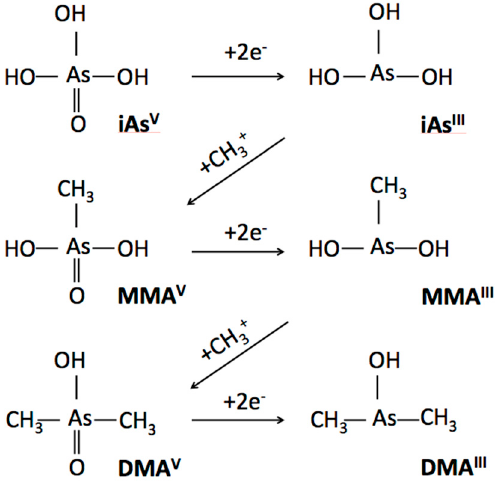
Figure 1. Arsenic biomethylation.